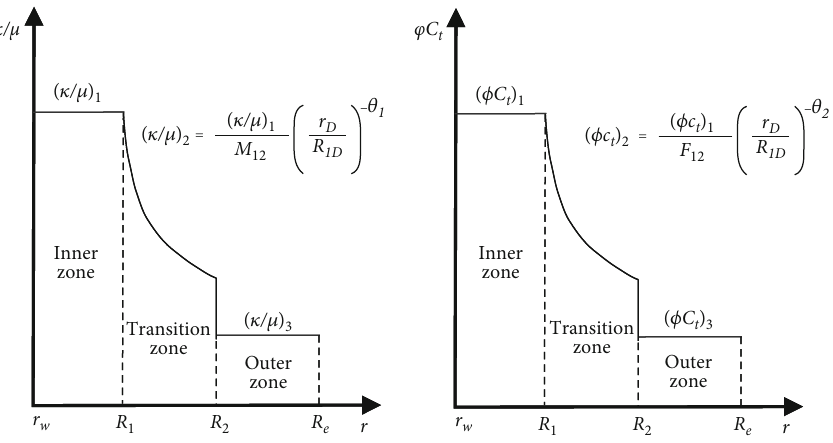
Figure 4: Schematic diagram of the mobility and storage coe ffi cient